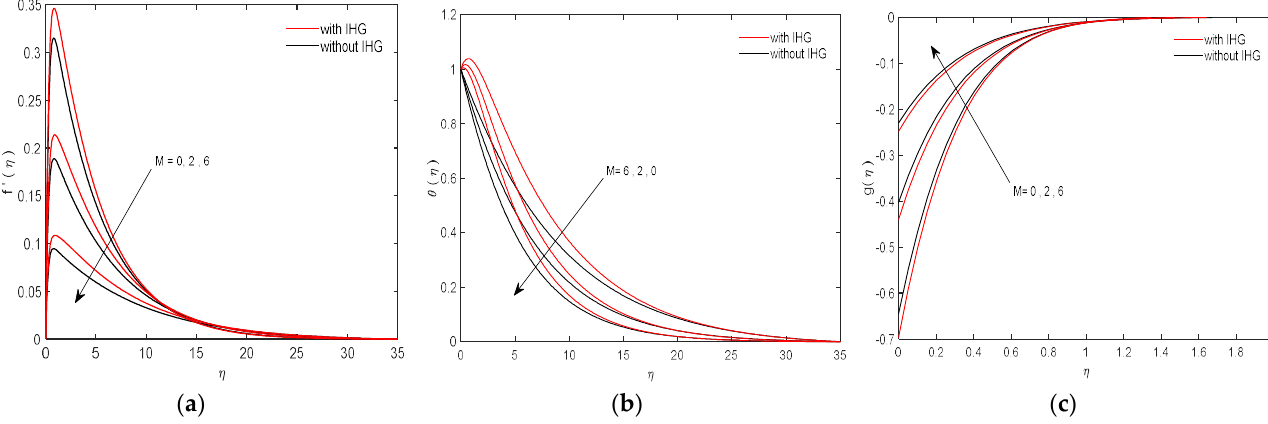
Figure 6. The effect of the magnetic parameter M on the ( a ) velocity profile, ( b ) temperature profile and ( c ) angular velocity profile for R = 0.5, λ = 0.5, c = 1, B = 0.2, φ 1 = φ 2 = 0.05, Da = 10, Rd = 2, n = 0.5, f w =